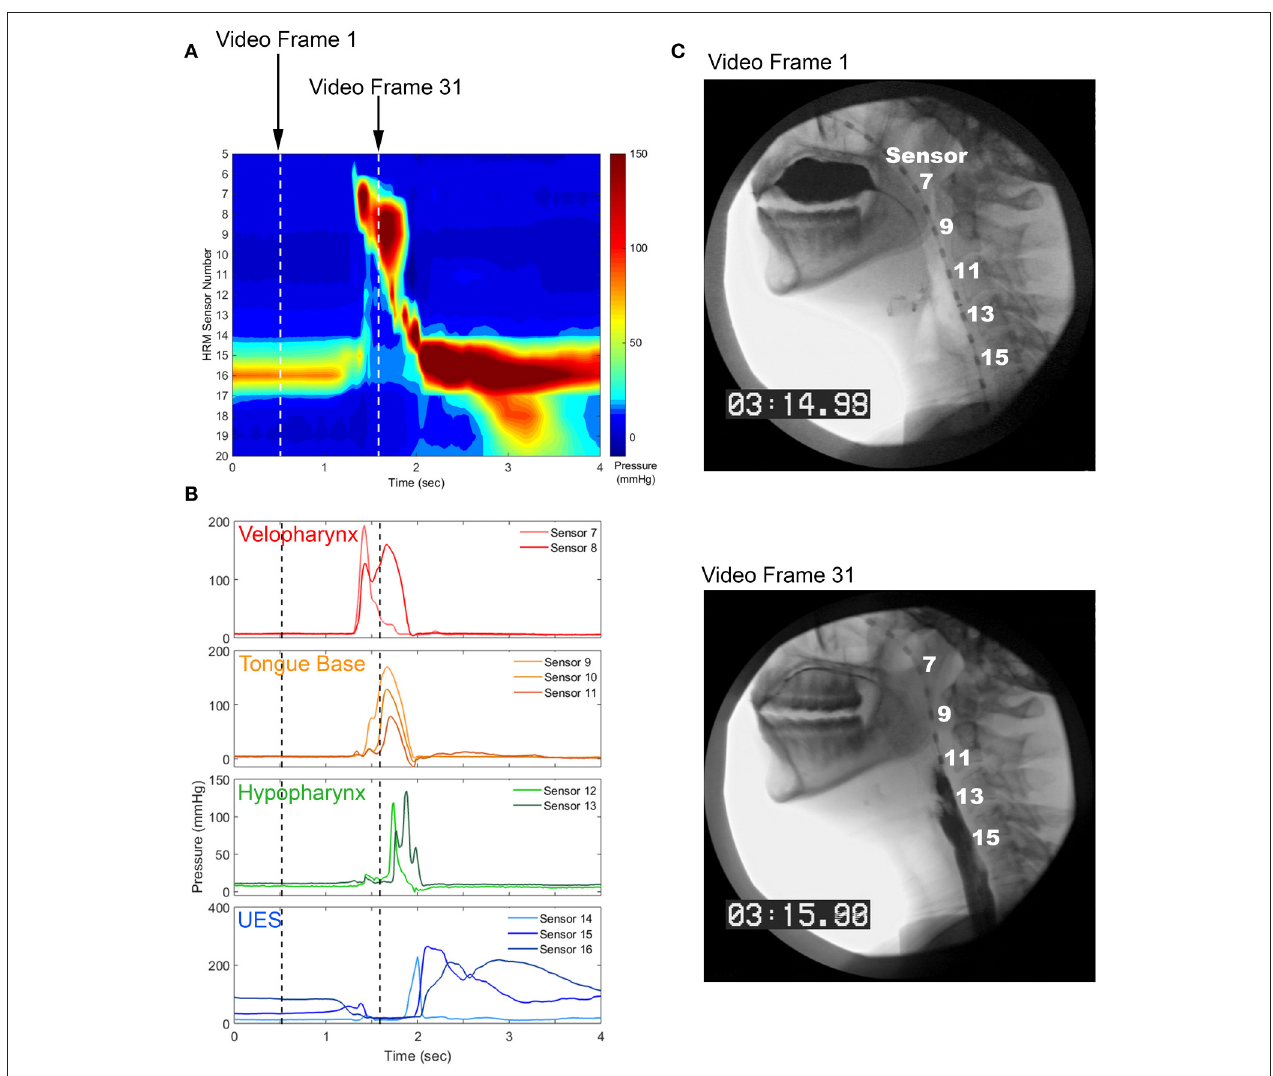
FIGURE 1 | Pharyngeal high-resolution manometry probe in situ and pharyngeal regions of interest. (A) High-resolution manometry spatiotemporal plot from a healthy, 24 year-old female. (B) Pressure waveforms used for pressure variability analysis. (C) Still image from concurrent